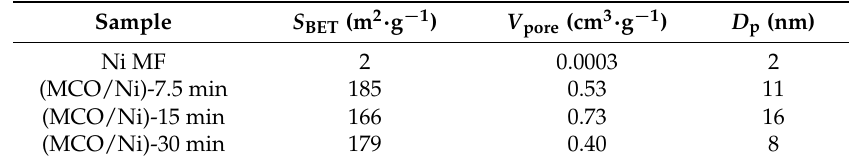
Table 1. Textural properties of Ni MF, (MCO/Ni)-7.5 min, (MCO/Ni)-15 min, and (MCO/Ni)-30 min.